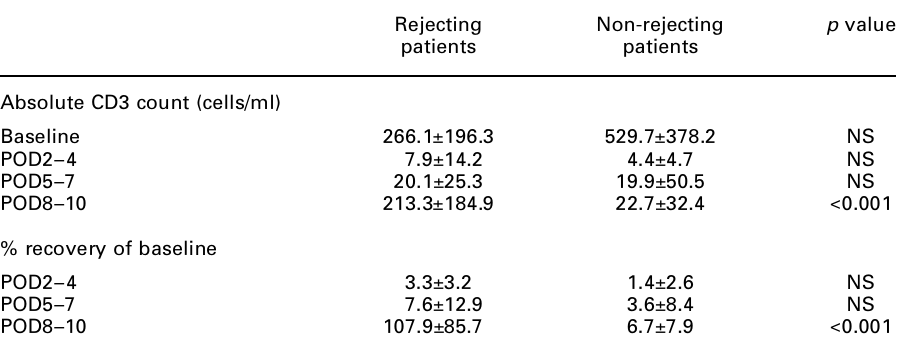
Table 2. T-cell recovery during OKT3 induction in liver transplant patients